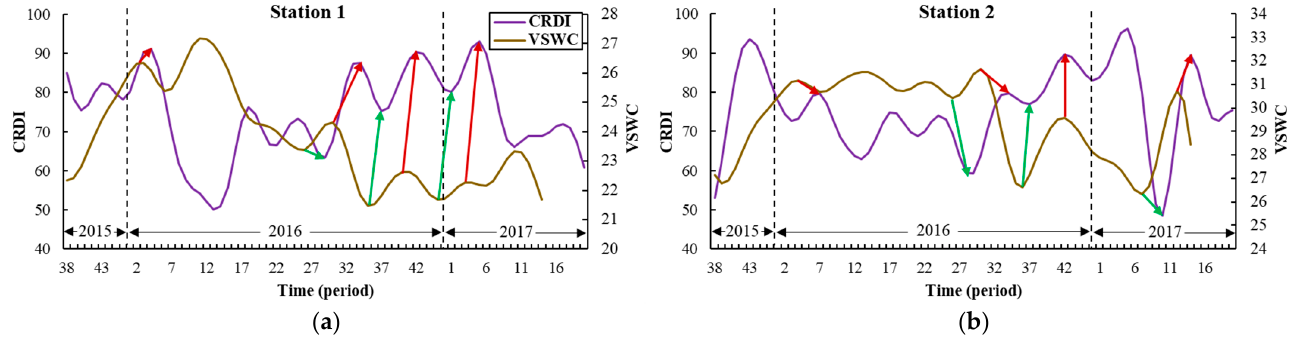
Figure 5. The indexes of CRDI and VSWC of station 1 ( a ) and station 2 ( b ). The red arrow represents the lag of the peak, and the green arrow represents the lag of the valley. The dotted line represents the division of years.